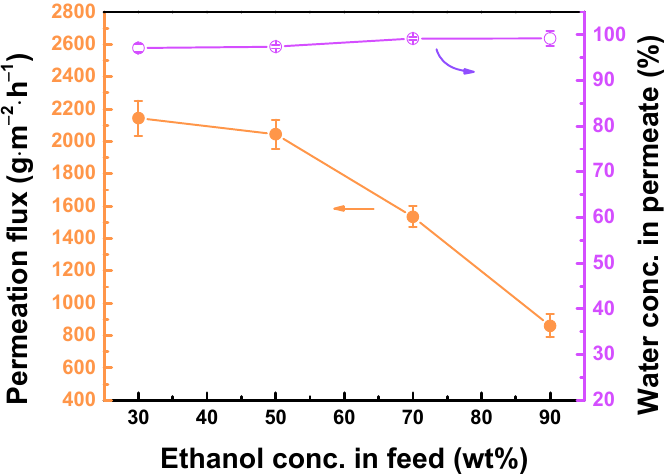
Figure 7. TFC isopentane membrane performance at different feed concentration. Feed = 30 − 90 wt% aqueous ethanol solution at 25 °C. Downstream pressure = 13 mmHg .